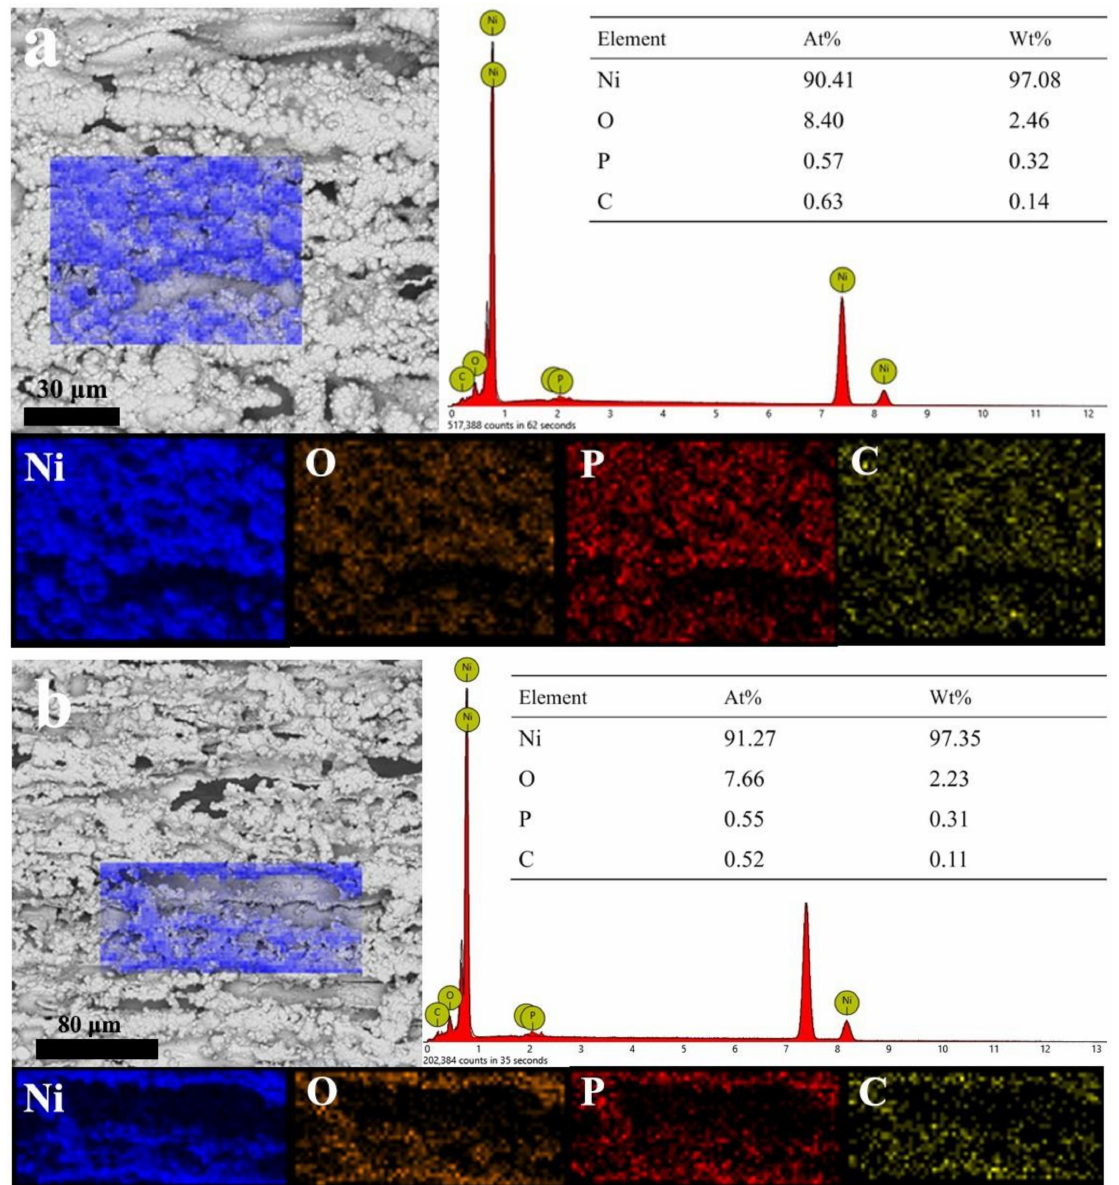
Figure 2. EDS surface scanning map of the first electroless Ni for 15 min and corresponding elemental mapping (( a ): region 1, ( b ): region